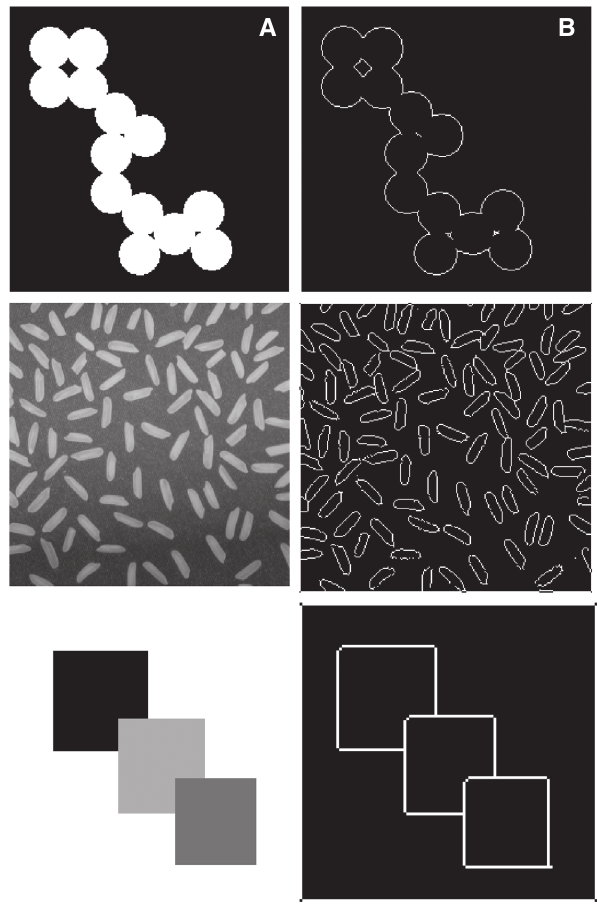
Figure 5. Experimental Results for Various Images. (A) Original image; (B) proposed